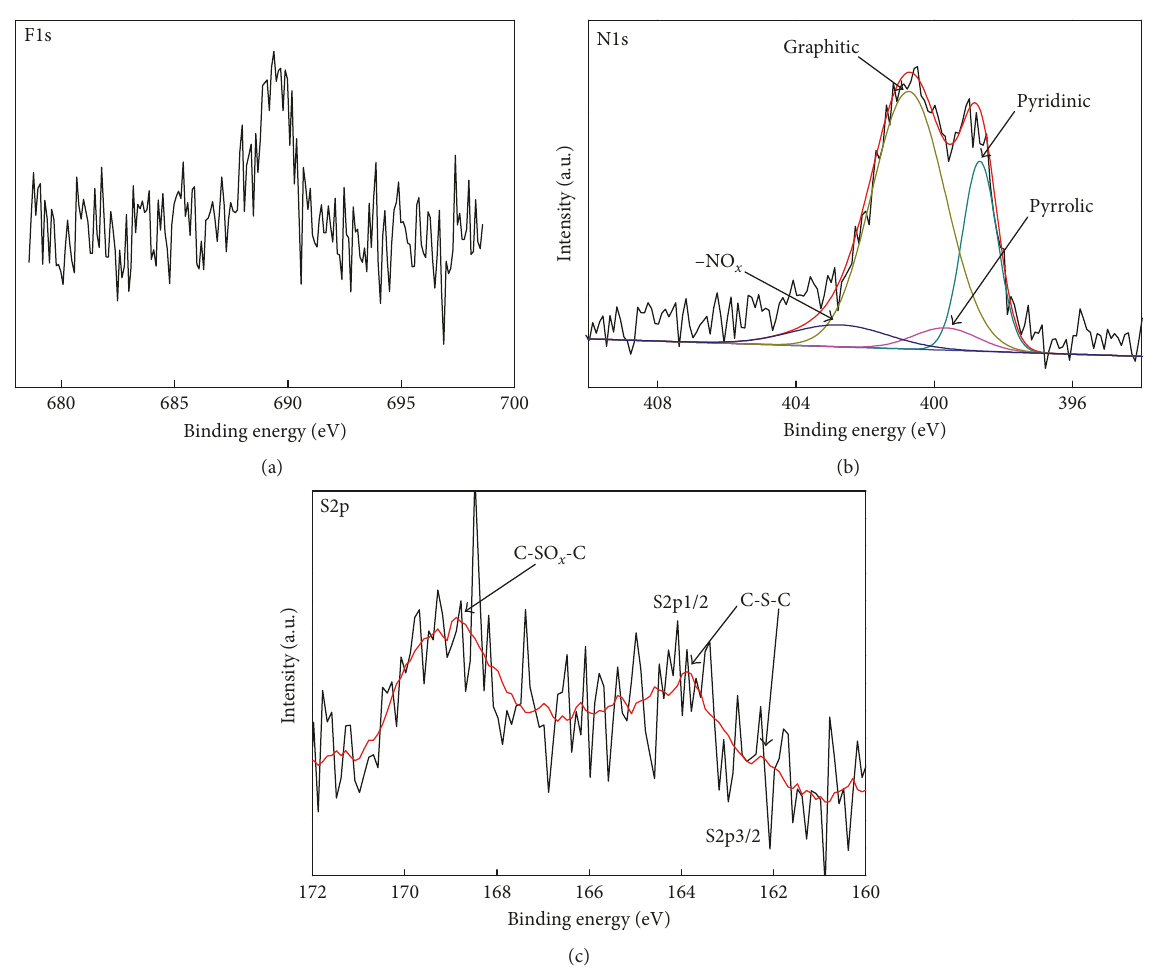
Figure 2: F1s, N1s, and S2p XPS spectra of